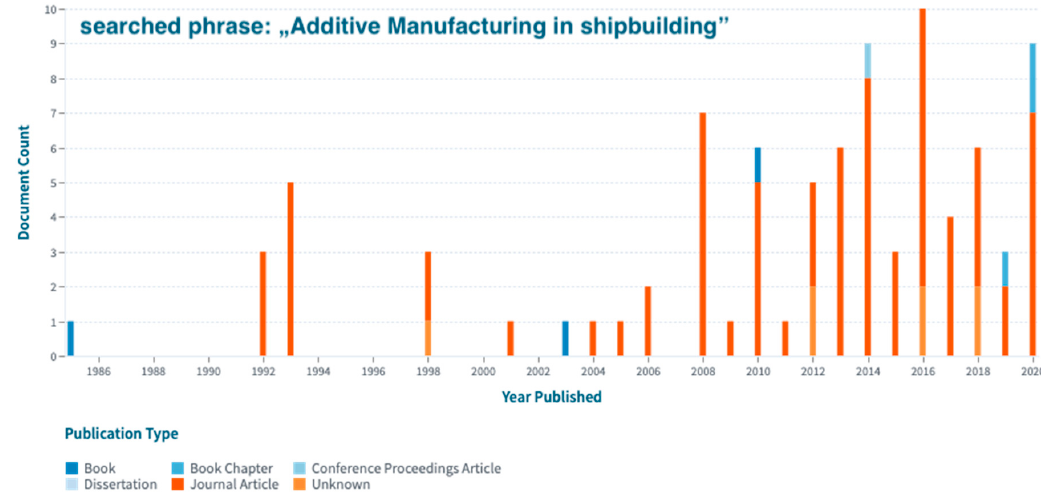
Figure 5. Number of publications related to searched phrase: “Additive Manufacturing in shipbuilding”, by lens.org (26.11.2020).